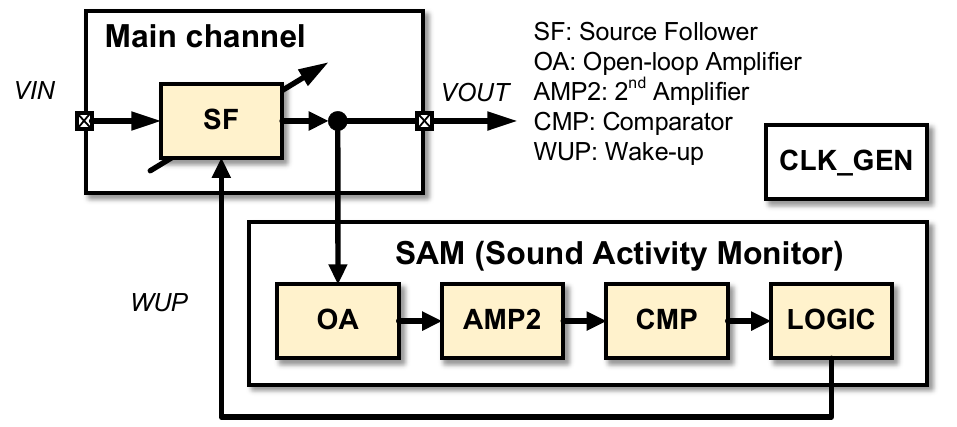
Figure 2. Top-level architecture of Sound Activity Monitor (SAM).